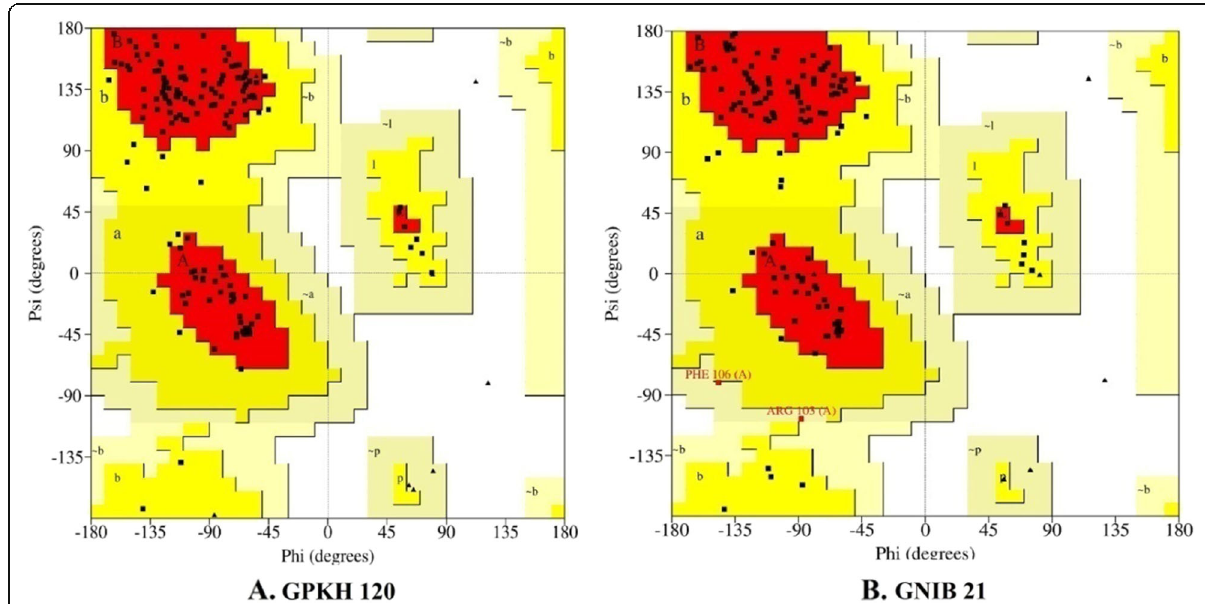
Fig. 3 Ramchandran plots of modelled TFL proteins from two genotypes of Indian bean. Ramachandran distributions of amino acids in the model were calculated with PROCHECK